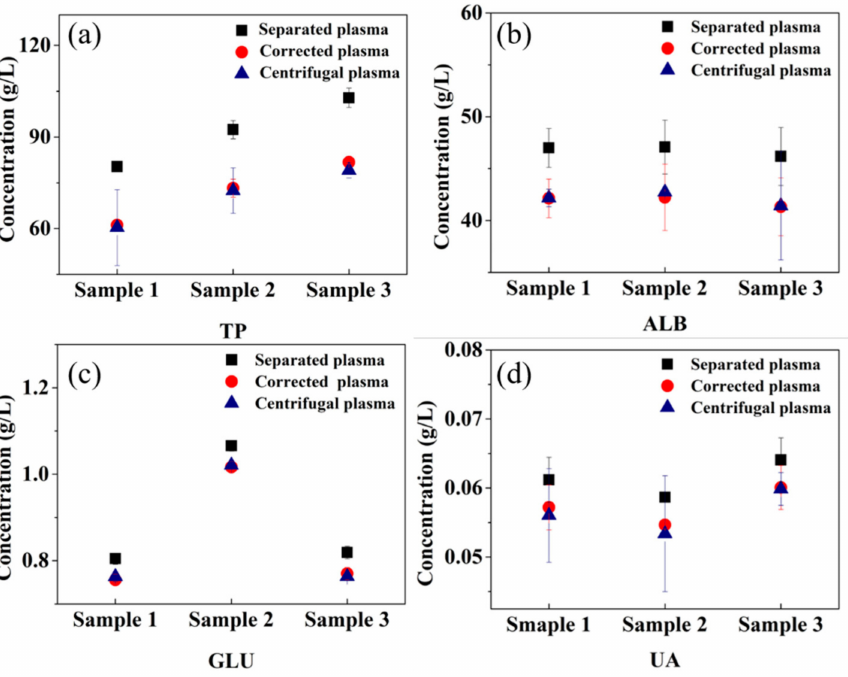
Figure 5. Component concentrations of clinical samples: ( a ) TP, ( b ) ALB, ( c ) GLU, and ( d )